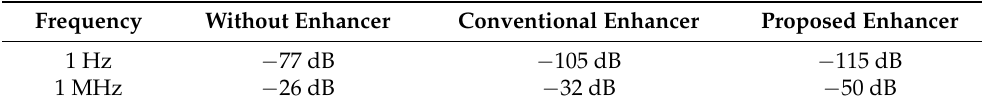
Figure 13. Comparison of PSR for DDA under different design cases. Table 5. Comparison of PSR at low and high frequency for DDA under different design cases powered about 1.1 V from the respective enhancer with 1.2 V supply.